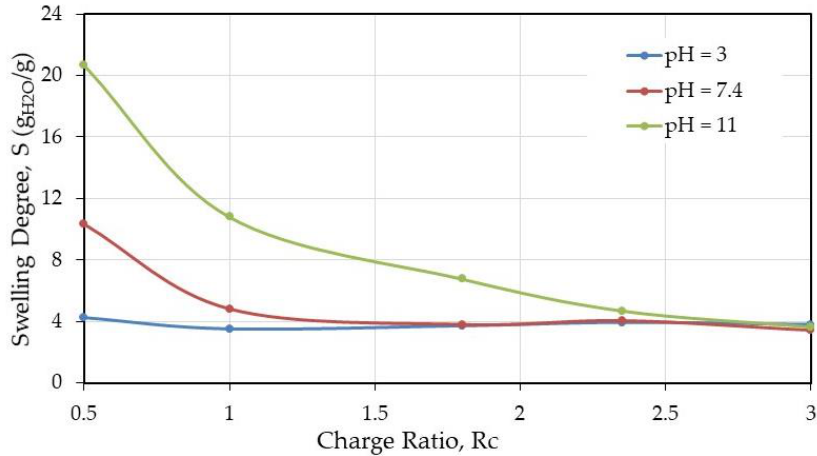
Figure 4. Swelling degree (g water/g dried material) as a function of the charge ratio after thermal treatment.